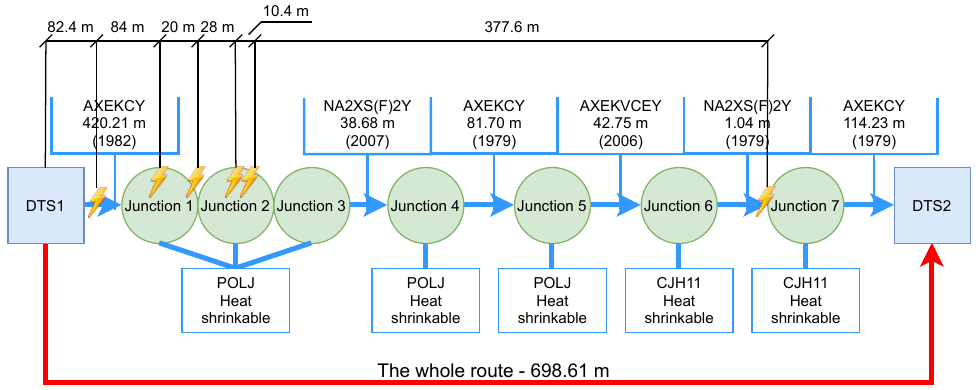
Figure 3. Measurement of the whole route showing cable types, junction types and measurements indicating partial